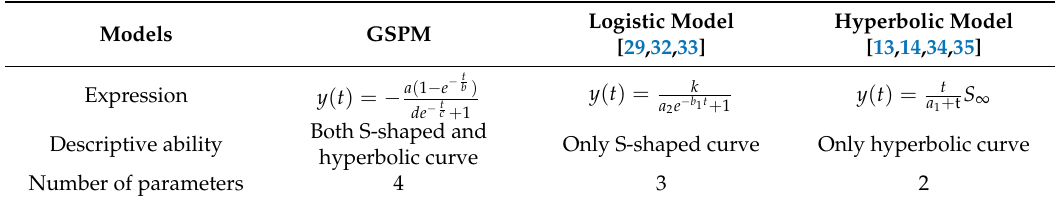
Table 1. Comparison of different prediction